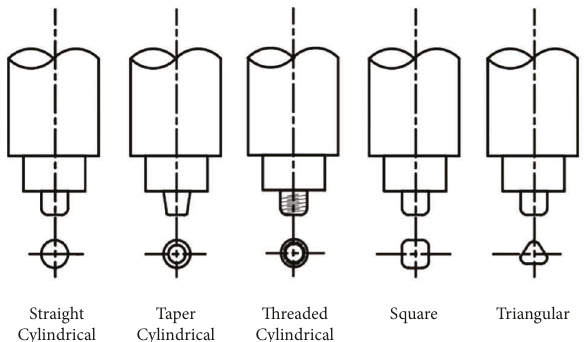
Figure 1: Illustrative diagram of different design of tool pin profiles